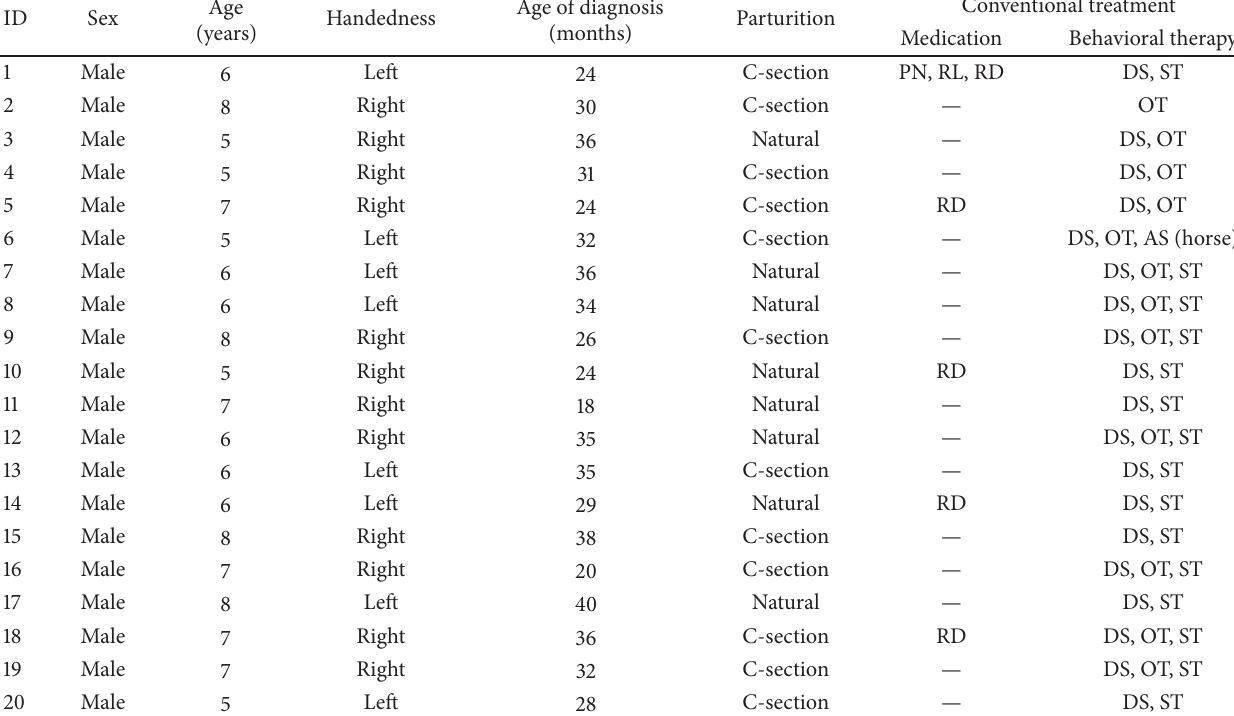
Table 1: Demographic data of participants ( 𝑛 = 20 ).